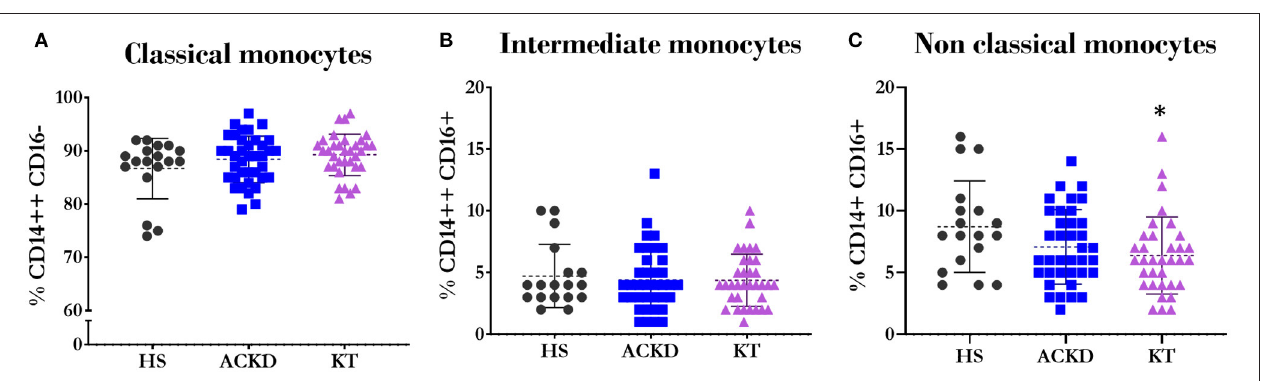
FIGURE 5 | Description of monocyte subsets. Percentage of classical Φ (A) (CD14 ++ CD16 − ); intermediate Ψ (B) (CD14 ++ CD16 + ) and non-classical Ψ (C) (CD14 + CD16 + ) monocytes in healthy subjects (HS), patients with advanced chronic kidney disease (ACKD), and patients with kidney transplantation (KT). * p ≤ 0.05 vs. HS. Statistical analysis: Ψ ANOVA (Tukey test). Ψ Mann–Whitney U -test. ANOVA, analysis of